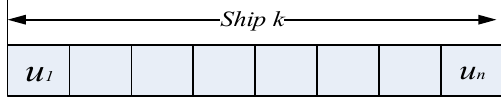
Figure 5. The encoding scheme of a particle position.